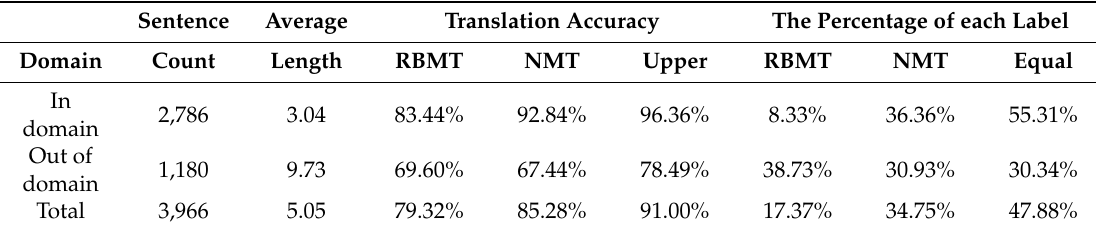
Table 3. Information of hybrid classification corpus.